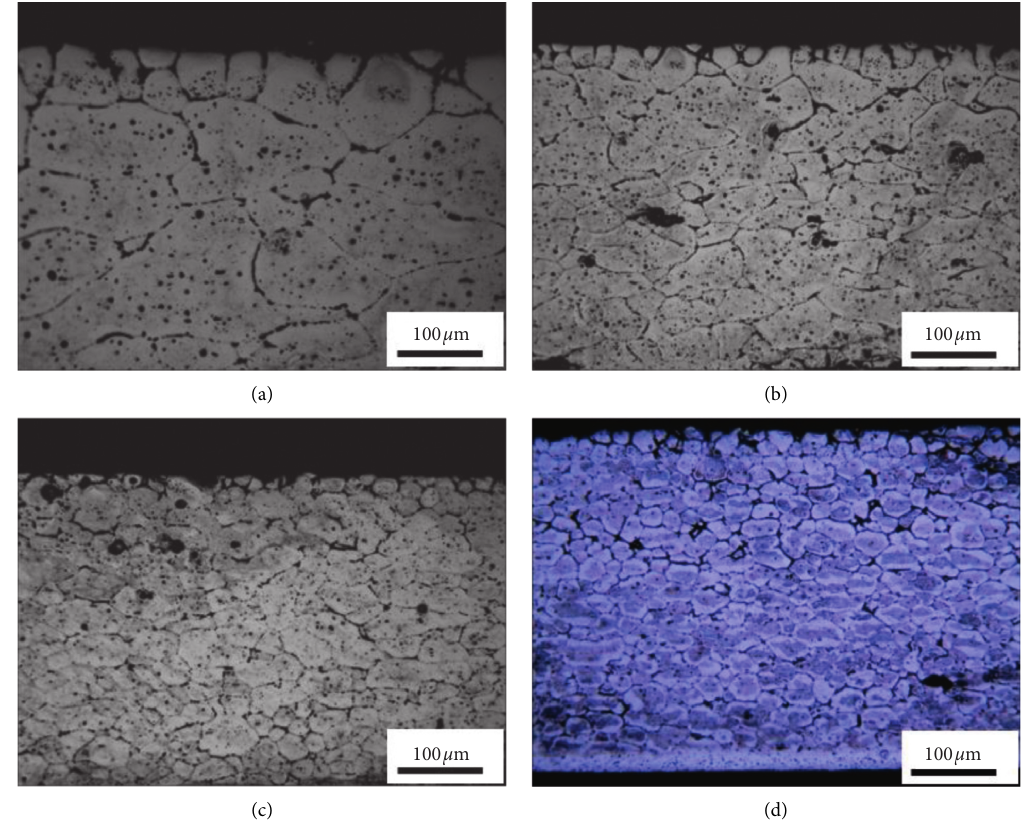
Figure 12: Cross-sectional microstructures of the brazed specimen annealed at 410 ° C and rolled to (a) 10%, (b) 20%, (c) 30%, and (d) 40%.